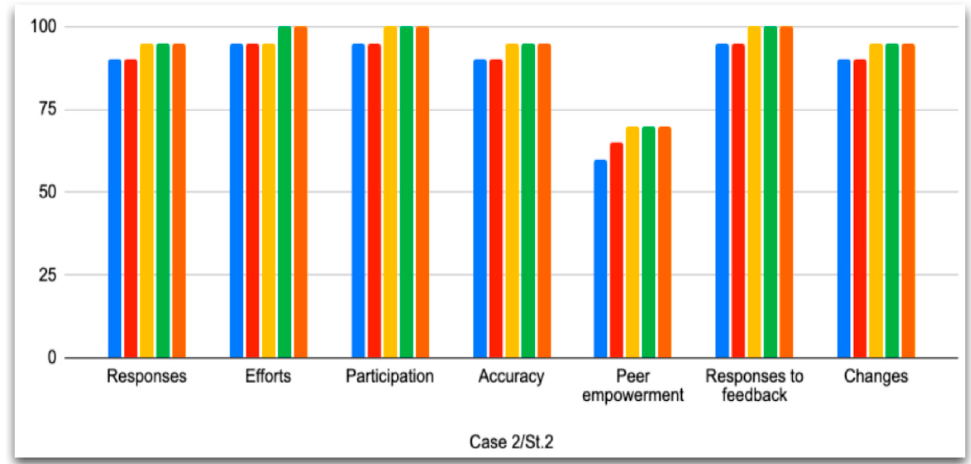
Figure 2. Vocabulary and spelling progress during alternative assessment online/Case 2.